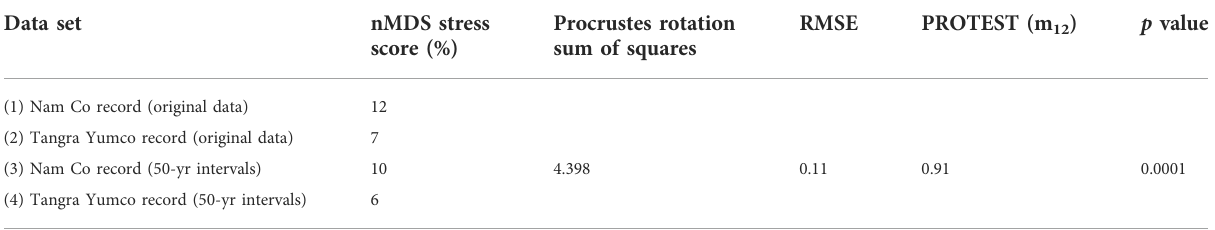
TABLE 2 Non-metric multidimensional scaling (NMDS) stress scores, Procrustes rotation and PROTEST diagnostics to show statistical comparison between the Nam Co and Tangra Yumco records. Data